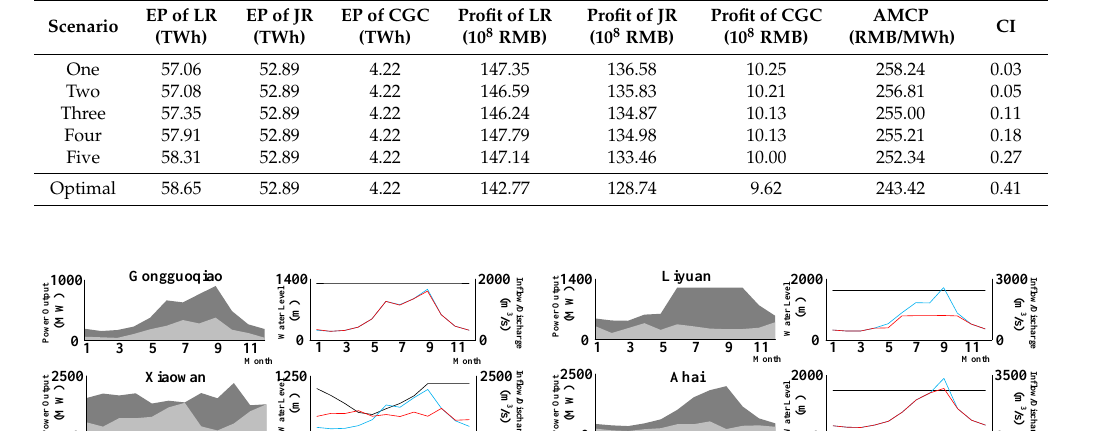
Table 3. Main market operation results in different regulation scenarios.